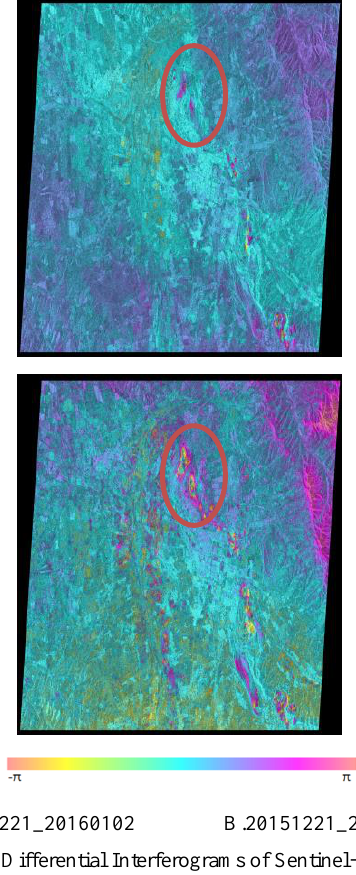
Fig.3 Differential Interferograms of Sentinel-1 data